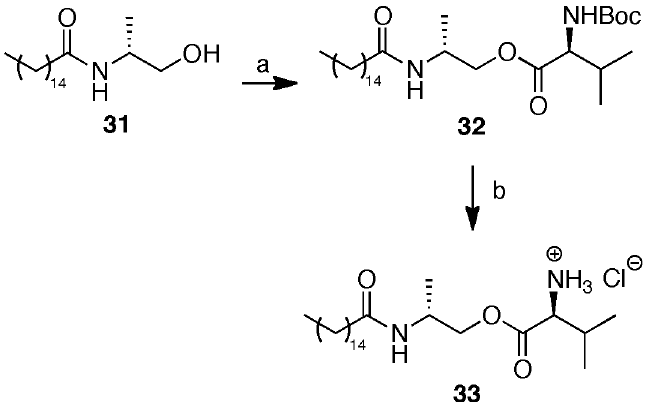
Fig 6. Synthesis of L-Val-( R )- α -methyl-PEA hydrochloride (33). Reagents and conditions: (a) N -Boc- L-Valine, DCC, DCM, 23°C, 12 h; (b) TFA/DCM 1:1 v/v, 0°C, 3 h then HCl, rt.